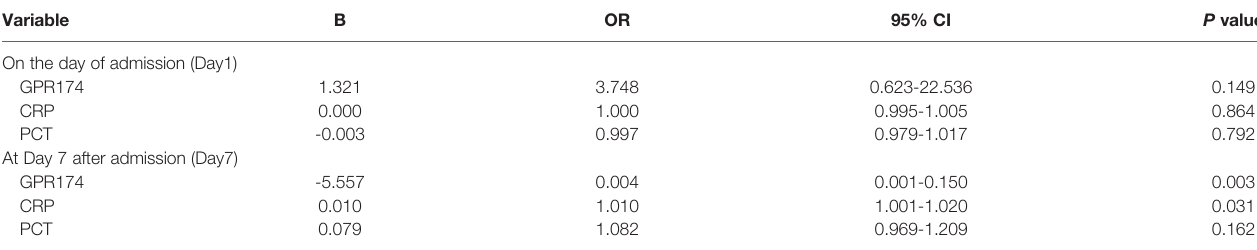
TABLE 3 | Independent factors predicting 90-day mortality in septic patients.